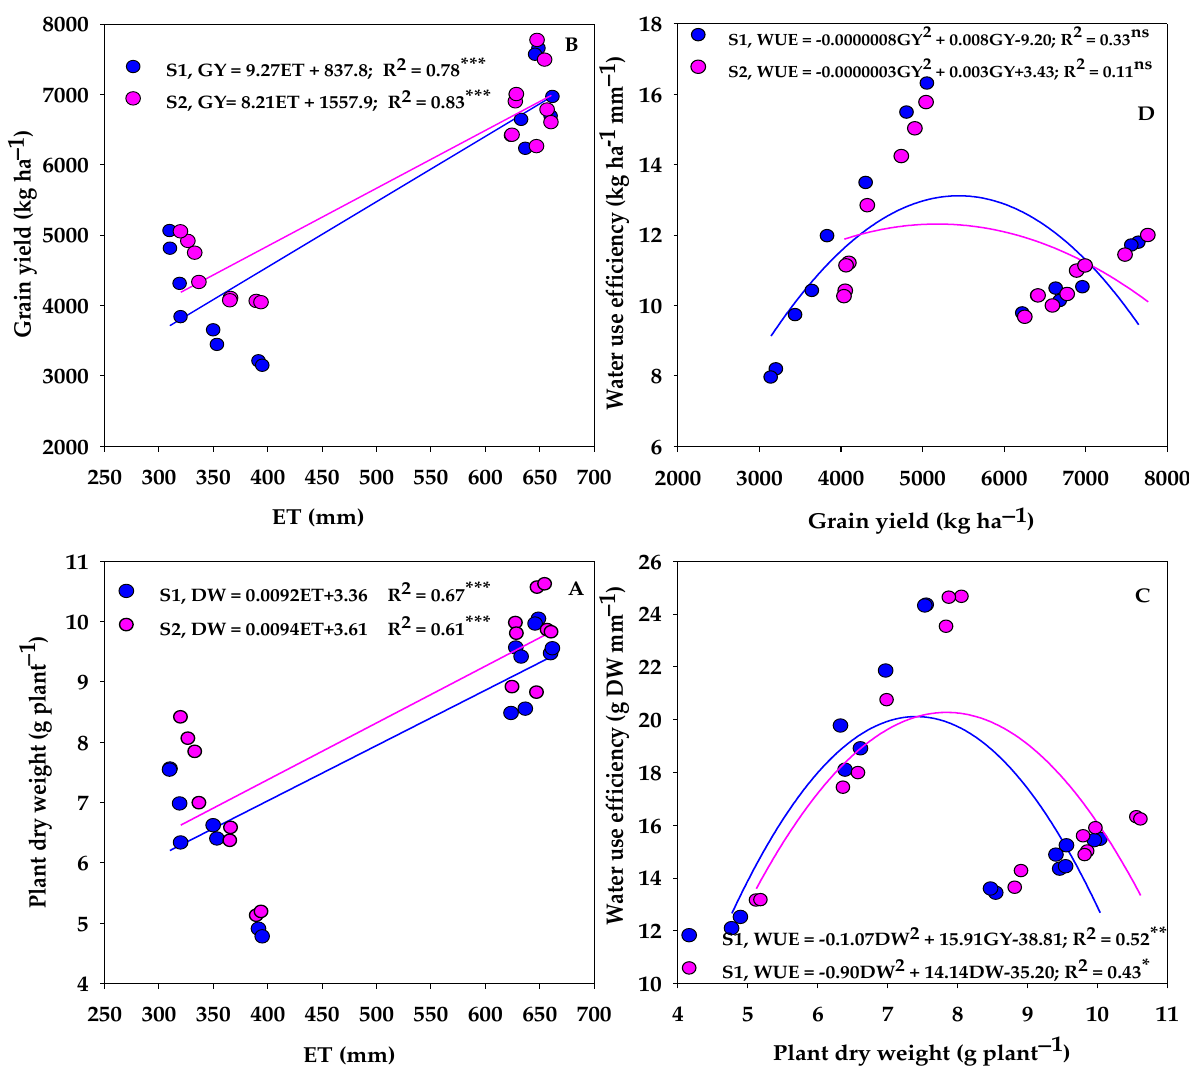
Figure 8. Relationship of seasonal evapotranspiration (ET) with plant dry weight ( A ) and grain yield ( B ) as well as relationship of water use efficiency with plant dry weight ( C ) and grain yield ( D ) in the first season (S1) and second season (S2). *,**, and *** indicate significant at p < 0.05, 0.01, and 0.001, respectively; ns indicates not significant.